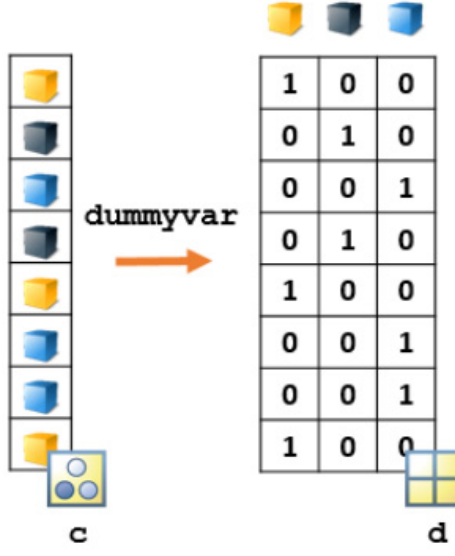
Figure 5. Network-topology schematization.